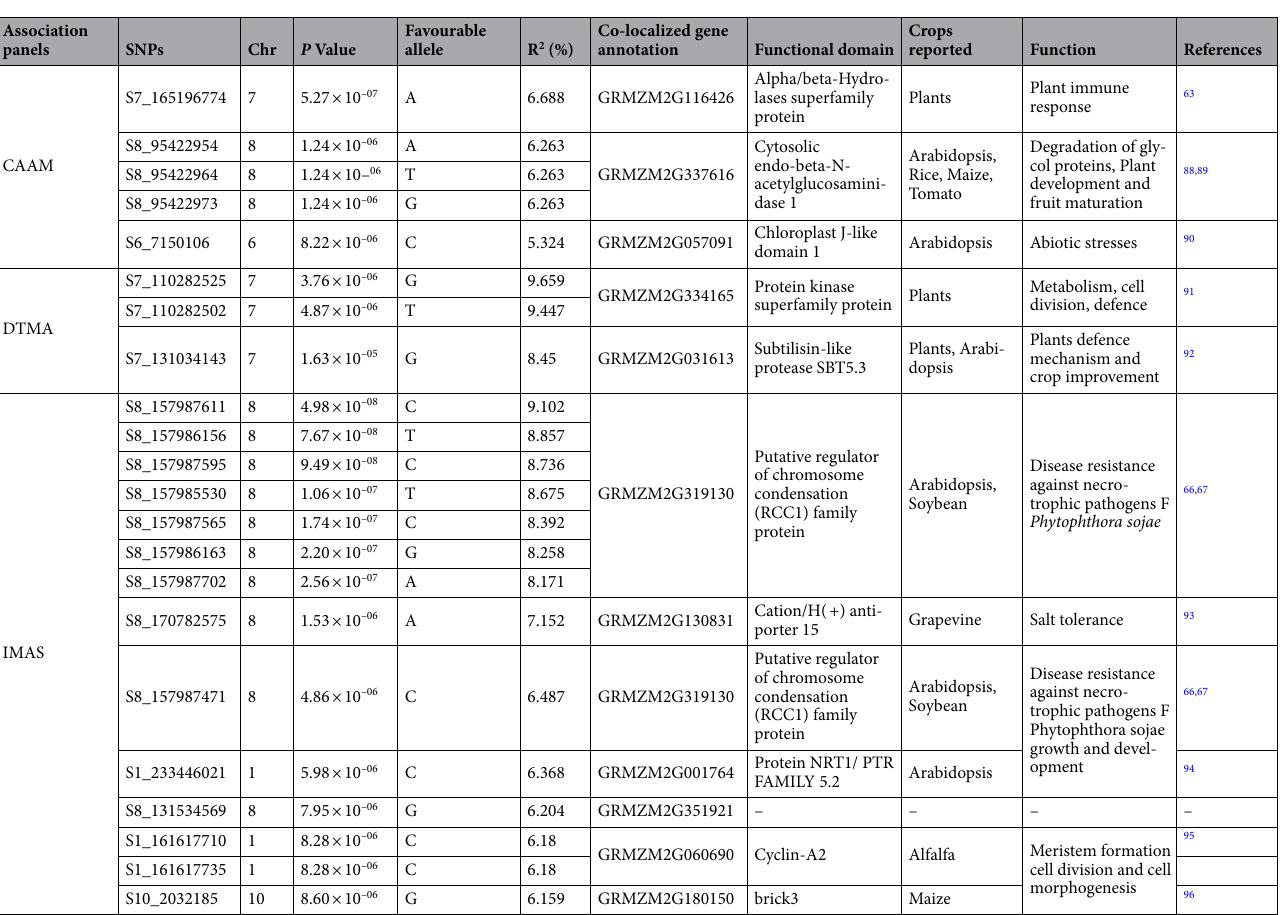
Table 4. Highly significant Single nucleotide polymorphisms (SNPs) identified in GWAS analysis of CAAM, DTMA and IMAS association panels that were evaluated NCLB